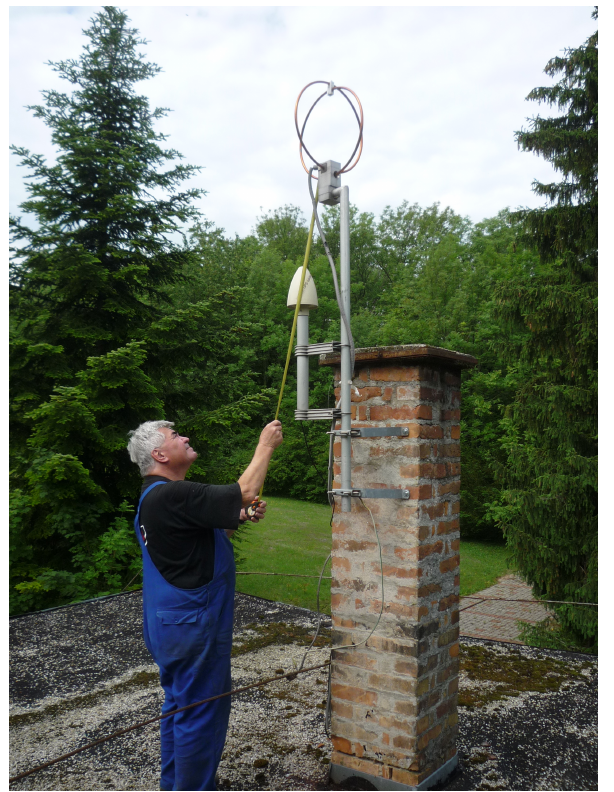
Figure 18. Gyula Pálla is adjusting the loop antenna of the LINET station on the roof of the office building at the NCK observatory. Note that the chimney is not